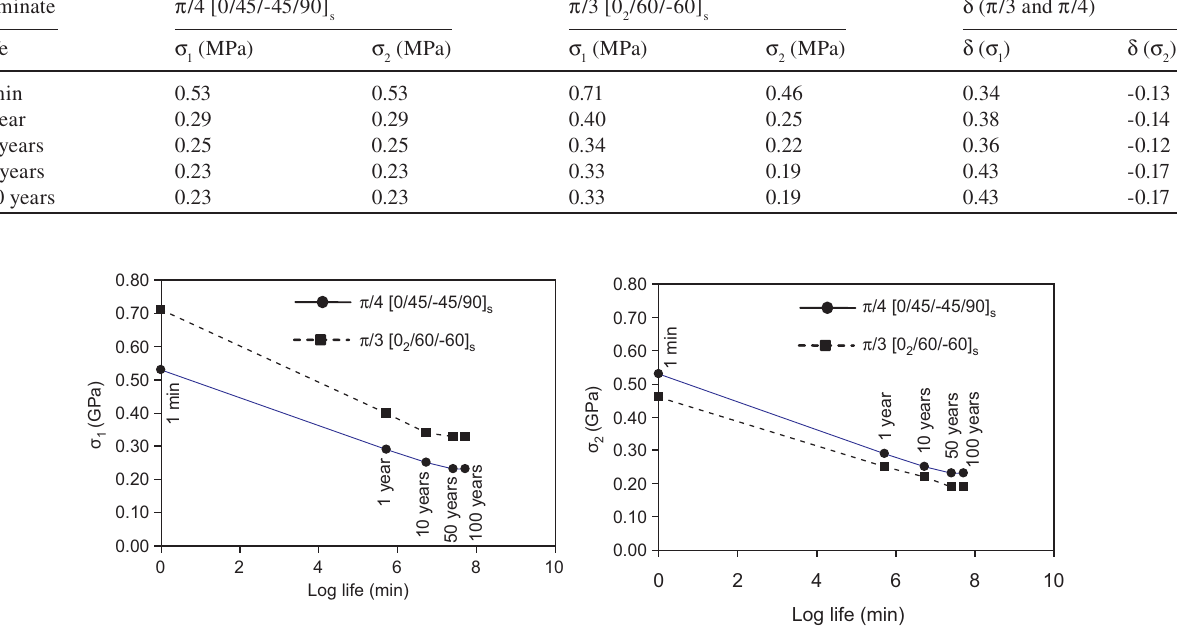
and σ failure stresses at different life for π /3 and π /3 laminates. 1 2